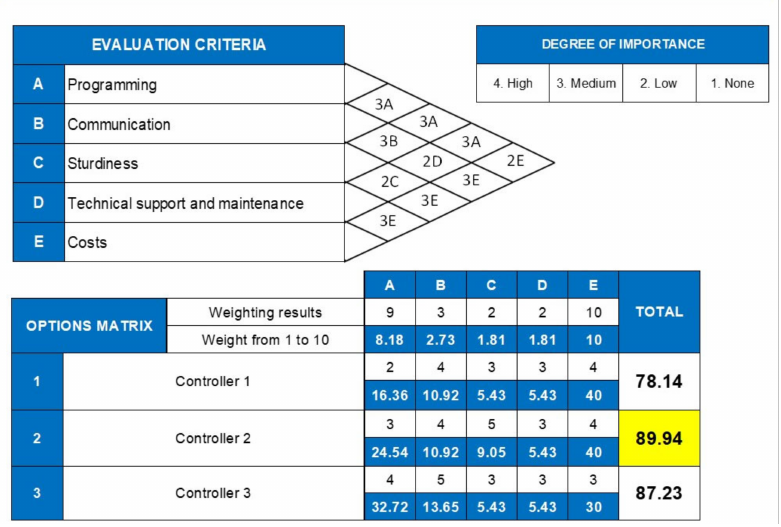
Figure 2. Evaluation matrix for control devices. Yellow Highlight: This is to highlight the highest score achieved in the technical comparison.